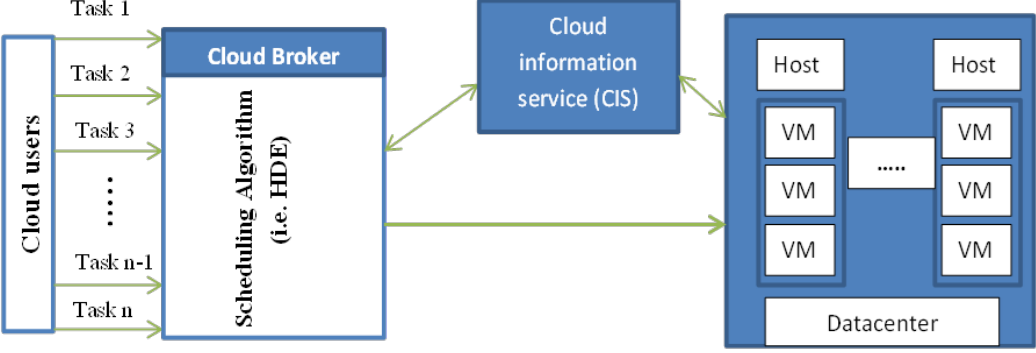
Figure 1. Task scheduling process in the cloud computing environment [4].